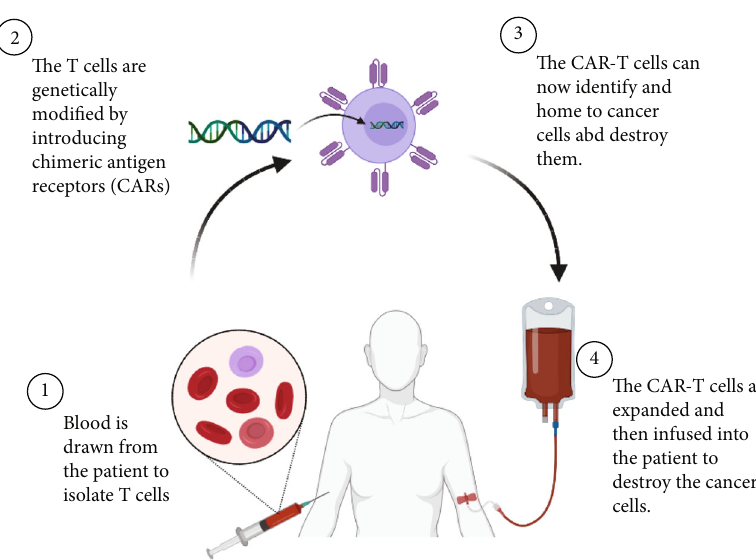
Figure 2: CAR-T cell therapy overview. The patients ’ T cells are isolated and genetically modi fi ed with a chimeric antigen receptors (CARs) that can home to cancer cells when infused back into the patients ’ blood